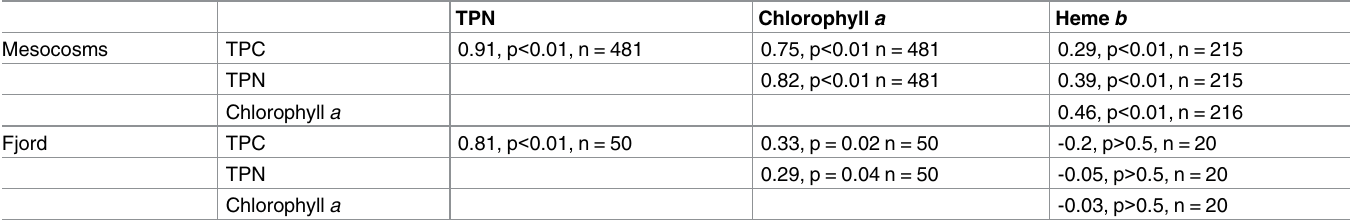
Table 1. Correlation coefficients observed for total particulate carbon (TPC), total particulate nitrogen (TPN), chlorophyll a and heme b concentra- tions in the mesocosms and Gullmar Fjord over the entire course of the